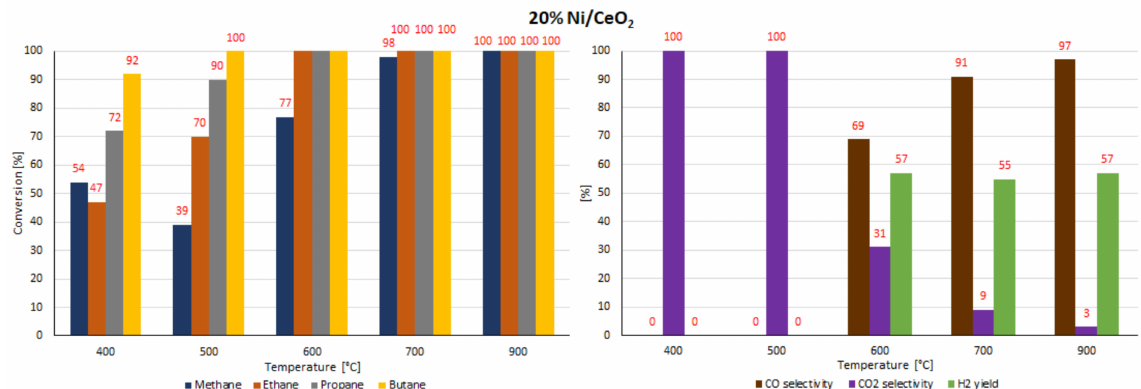
Figure 16. The activity results of the 20% Ni/CeO 2 catalyst in the OSR-LNG process.